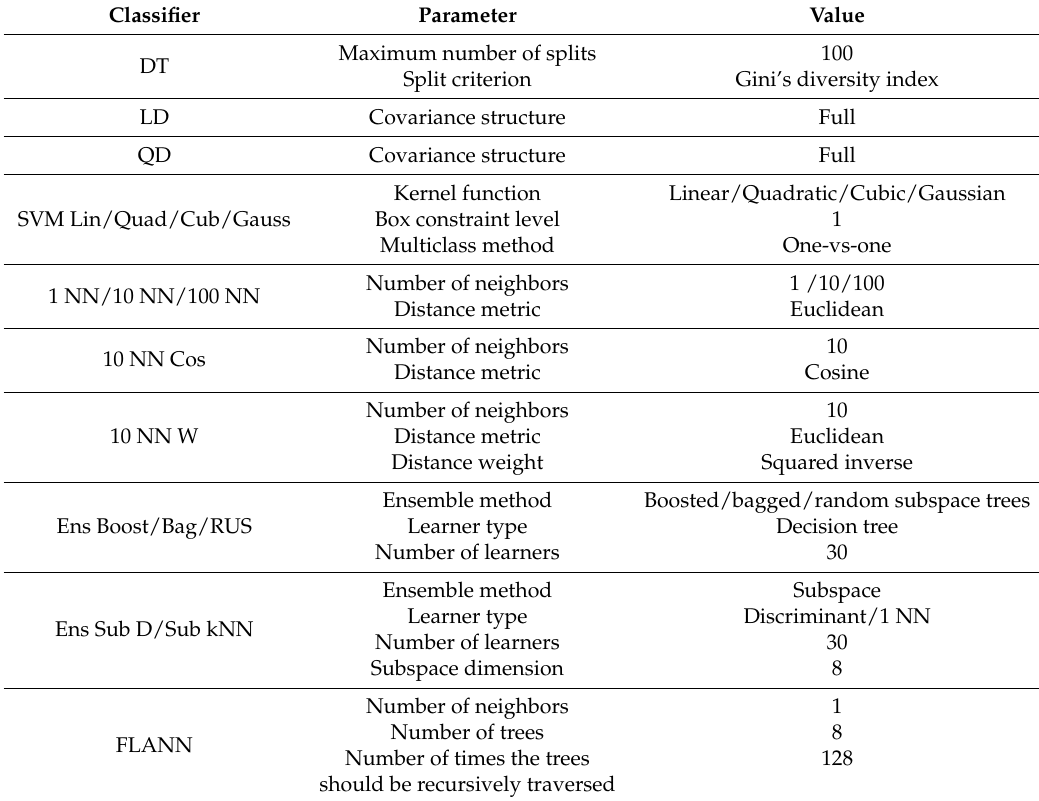
Table 2. Tested classifiers and their